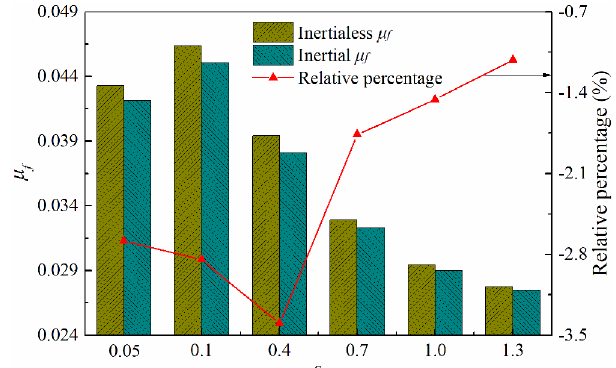
Fig. 17. Comparison between friction coef fi cient with and without inertia forces at varied applied slide-roll ratio.